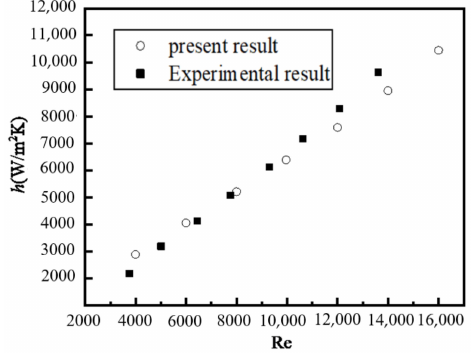
Figure 3. Relationship between h and